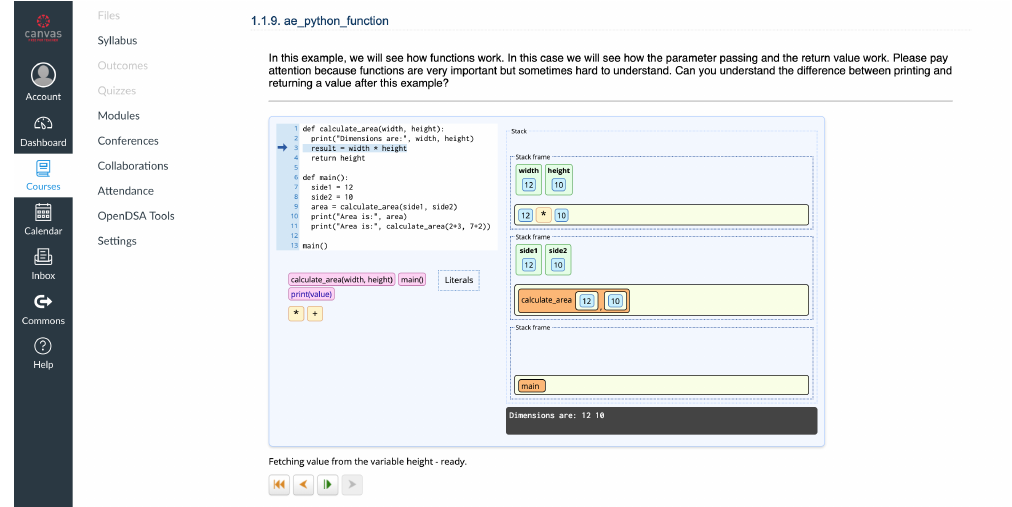
Figure 10. Python function animation (served by ACOS) made available within an OpenDSA eTextbook, delivered via